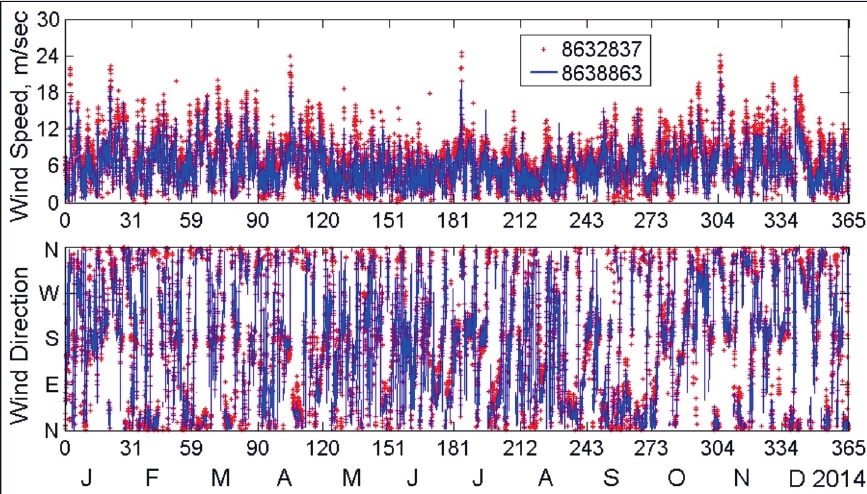
Figure 7. Wind measurements at Rappahannock Light, VA (8632837) and Chesapeake Bay Bridge Tunnel, VA (8638863) for 2014.